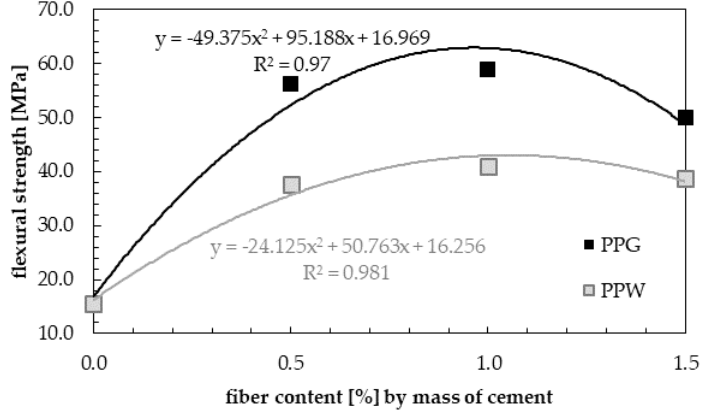
Figure 15. Flexural strength of hardened samples with PPG and PPW.